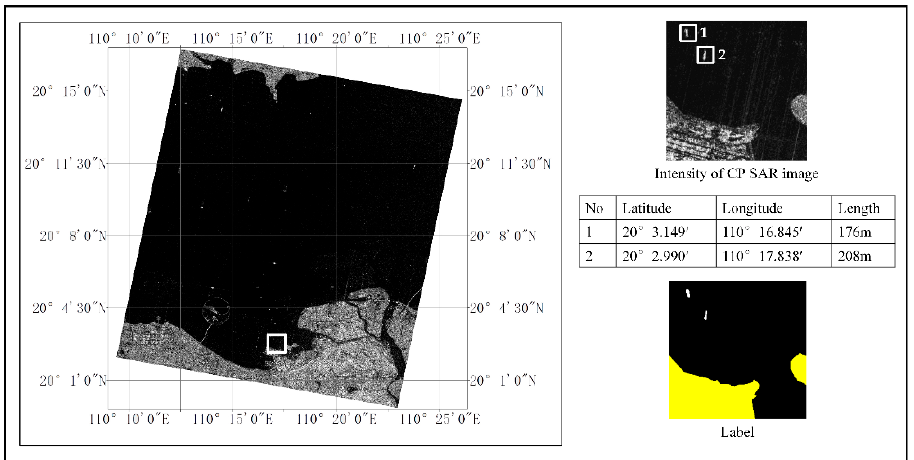
Figure 3. Illustrations of a compact polarimetric synthetic aperture radar (CP SAR) image (left), a sub-image (top right), corresponding automatic identification system (AIS) information (mid right), and label image (bottom right). The AIS information includes longitude, latitude, and ship length. Land is yellow, the ships are white, and the sea is black.